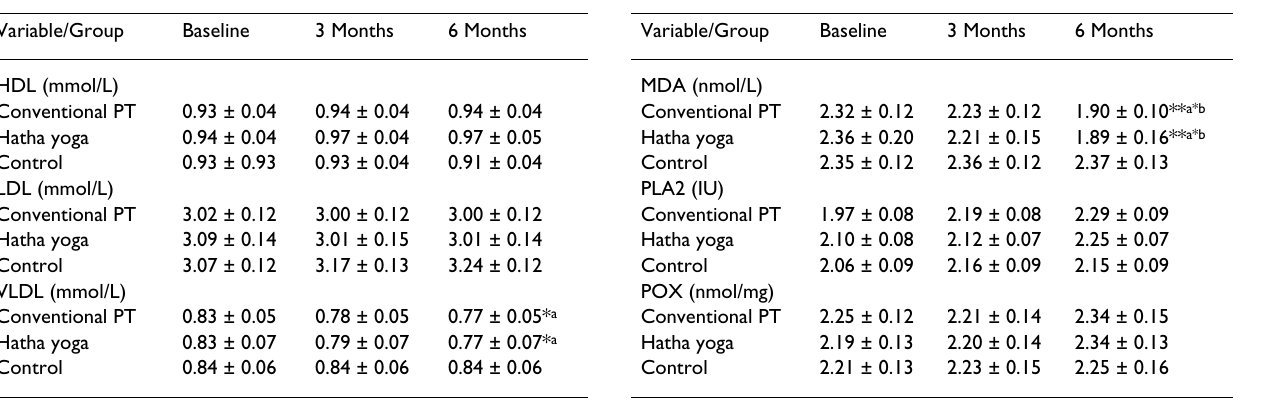
Table 4: Comparison of MDA, PLA2 and POX concentrations among conventional PTexercise, Hatha yoga exercise